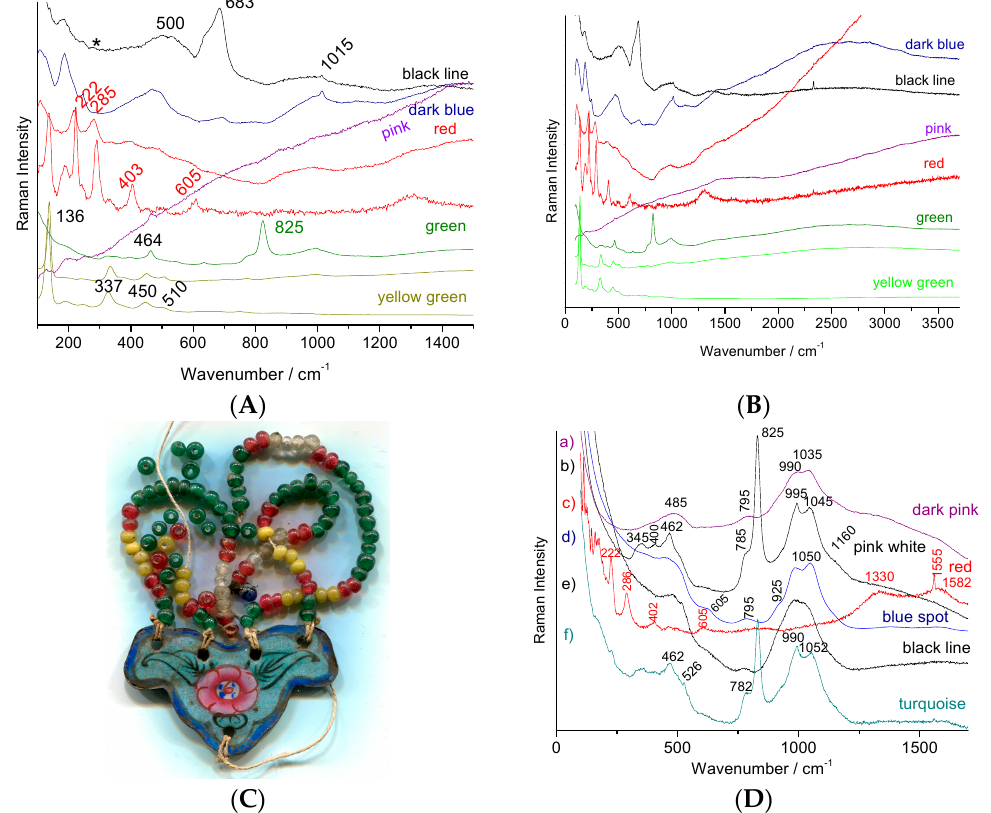
Figure 11. ( A , B ) Raman spectra representative of the decoration of a British faience (W. Brownfield factory, see Figure 2f), on the left zoom of the spectral domain characteristic of the fundamental modes; ( C ) photography and ( D ) Raman spectra of a Chinese necklace representative of enamel on copper with enameled pendant (Canton, Figure 2e); colored areas examined are given. Band with a * arise from the filter.